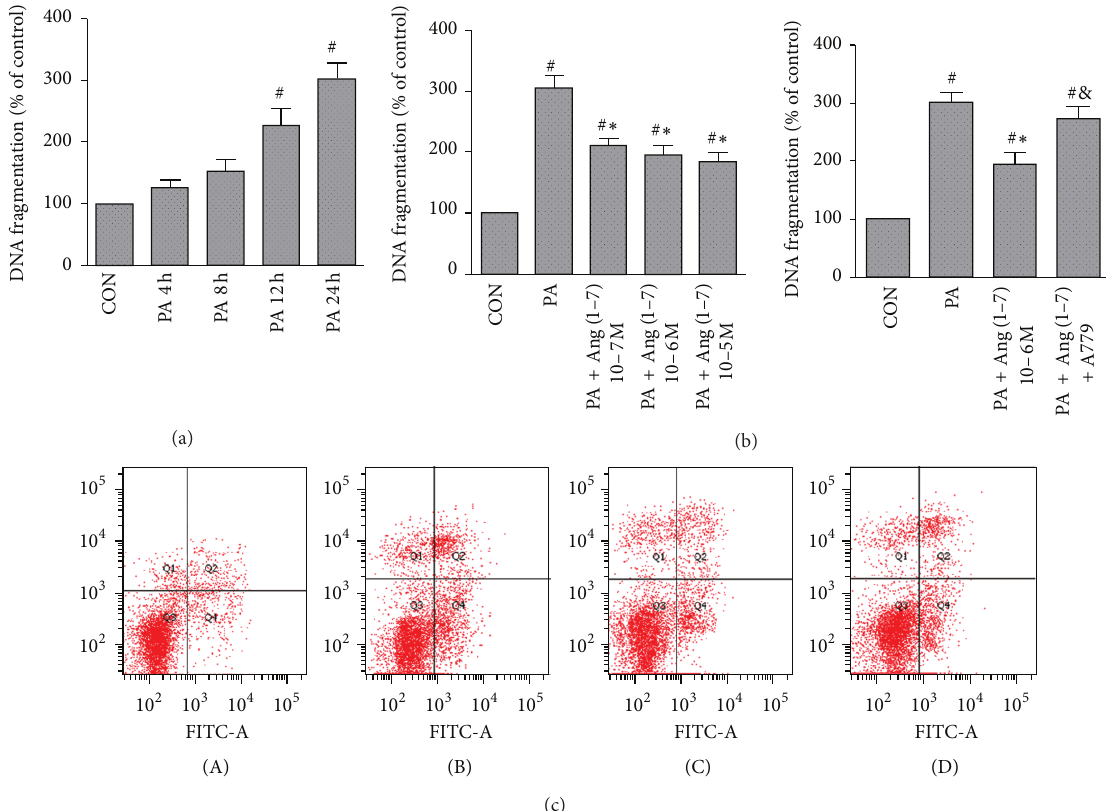
Figure 2: Ang (1–7) blocked palmitate-induced apoptosis in MS-1 cells. Lipoapoptosis depends on the exposure time (a). DNA fragmentation (b) and flow cytometry (c) measured in MS-1 cells exposed to palmitate (0.25mmol/L) for 24 h, alone or in combination with Ang (1–7) (10 −6 mol/L) or A-779 (10 −5 mol/L). (c)(A): CON group; (c)(B): PA group; (c)(C): PA + Ang (1–7) group; (c)(D): PA + Ang (1–7) + A779 group. Values are mean ± SEM, 𝑛 = 4 for each group. # 𝑃 < 0.05 versus CON; ∗ 𝑃 < 0.05 versus PA; & 𝑃 < 0.05 versus PA + Ang (1–7).